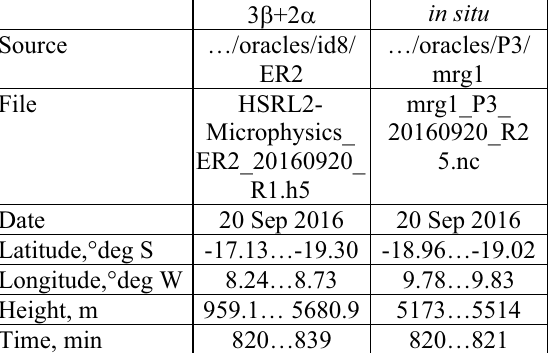
algorithm at 5.7 km (solid black, gray and green